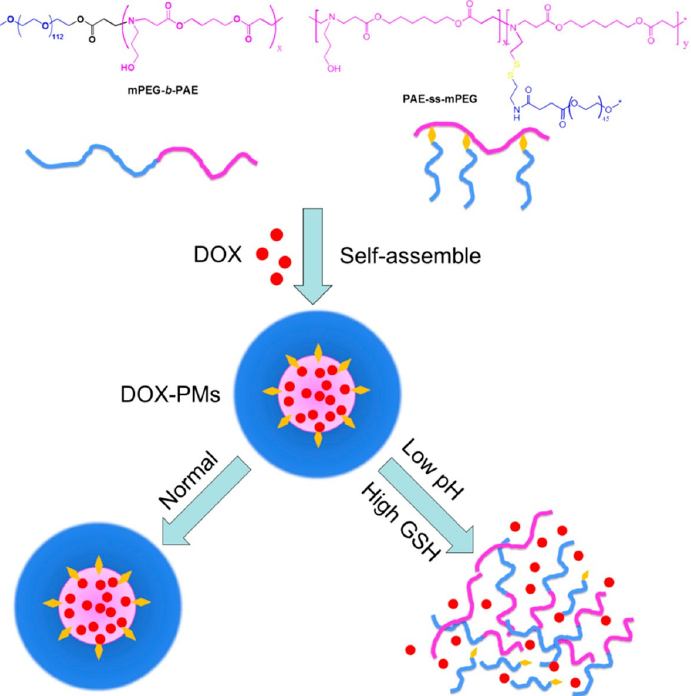
Figure 7. Co-micellization of pH/redox-responsive diblock copolymers for drug delivery and con- trolled release triggered by pH and glutathione (GSH). DOX: Doxorubicin; PMs: polymeric micelles. (Reprinted with permission from Ref. [131]. 2019, Yongle Luo).